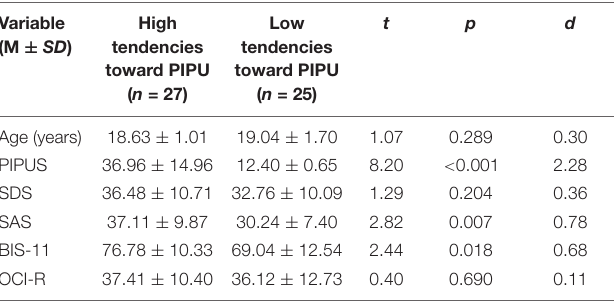
TABLE 1 | Descriptive statistics of the participants with high tendencies toward PIPU vs. low tendencies on questionnaires.